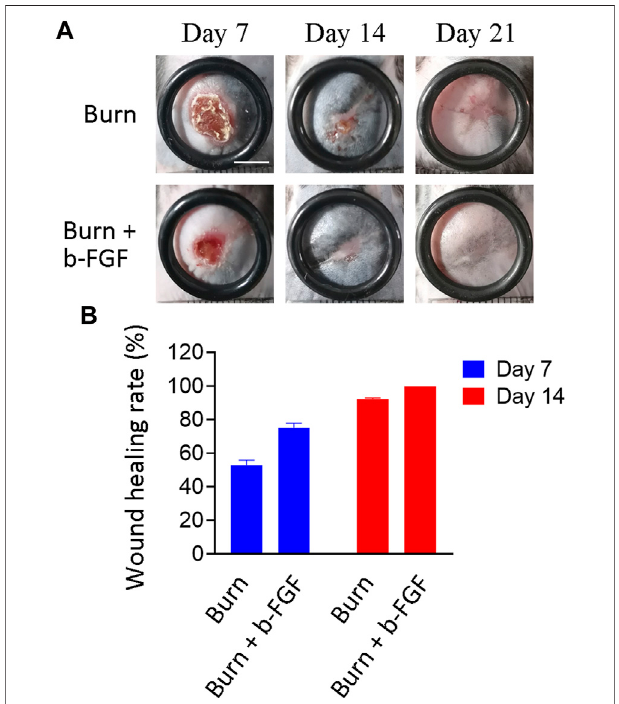
FIGURE 2 | Wound healing of deep burns in mice. (A) Images of the deep burns in different groups. Scale bar = 50 mm. (B) Wound healing rate of the deep burns was measured (n =